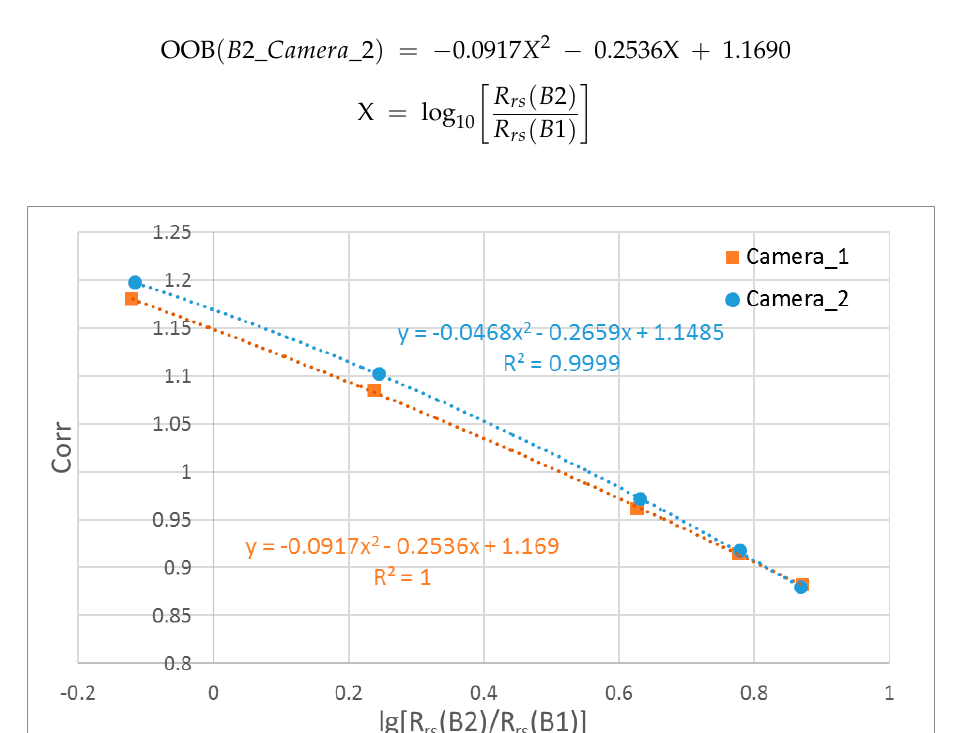
Figure 6. Estimation of the OOB correction factor for the CZI green band in Case 1 water from band ratios of CZI remote sensing reflectance.